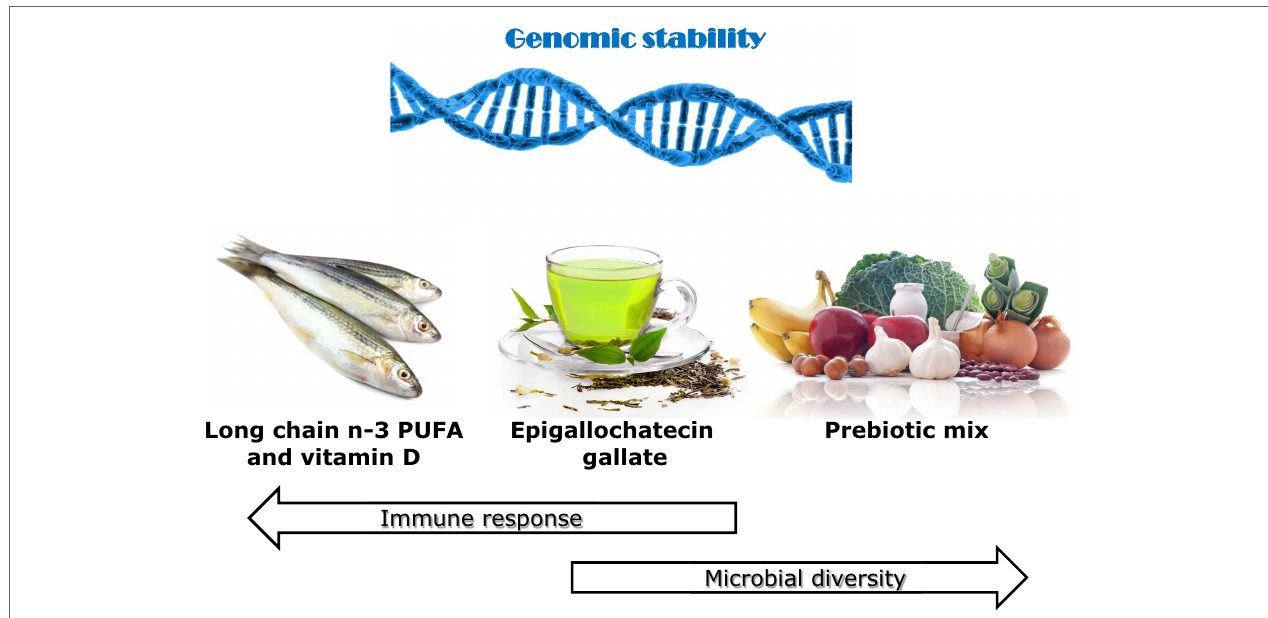
FiGURe 1 | effects of various identified dietary components on immune response, microbial diversity, and genomic stability, with use justified by genetic testing . The use of the immunochip supplemented with fine mapping enables very detailed understanding of the nature of the genes involved in CD susceptibility of an individual. A number of the affected genes play key roles in inflammatory response. If the majority of the affected genes favor inflammation, then a primary recommendation may be to enhance the intake of long-chain n -3 PUFA, especially EPA and DHA. Both of these play distinctive and major controlling roles in inflammatory response (16). If genes affecting microbial response and signaling pathways predominate, then probiotics may be an especially important dietary component (35). In addition, various prebiotics such as the food combination illustrated here act to stimulate the growth of beneficial gut microbes (14, 37). Both vitamin D and various phytochemicals, including the active component in green tea, EGCG, are recognized as having roles in each of these processes and are likely to be beneficial to CD patients at higher than standard dietary recommendations (15, 38–40). Maintenance of genomic stability will play an important role in slowing progression of CD or the development of CRC (7, 21). Thus, diets containing a good balance of such components, possibly tailored according to genotype, may act to complement or slow the need for recognized therapeutics in CD. Images from Can stock